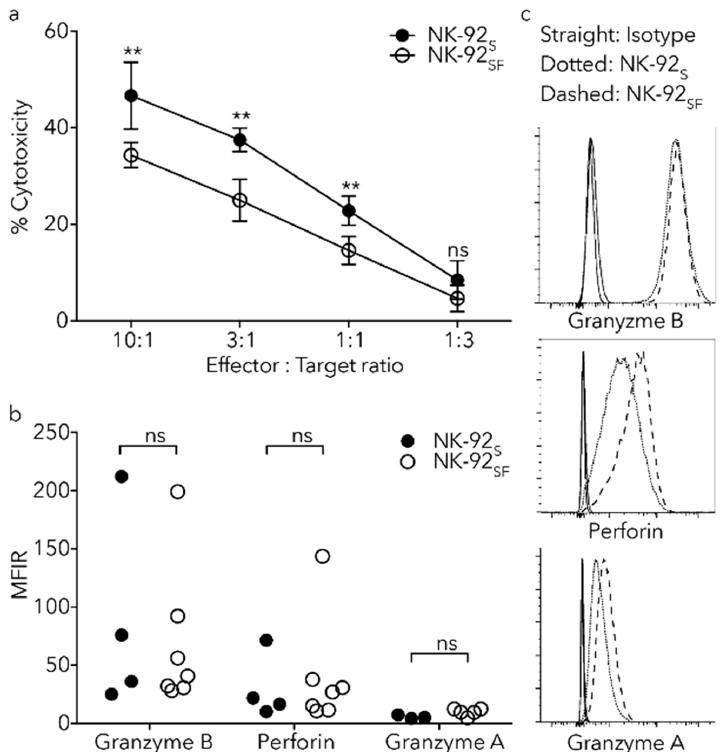
Figure 5. Reduced degranulation rate and cytotoxicity against K562 in NK-92 SF cells. ( a ) Chromium release assay, with K562 cells as target cells, show reduced cytotoxicity in NK-92 SF cells at designated effector:target ratios. Each data point represents the mean (+SD) of two independent assays performed in triplicates. ( b ) Load of Perforin, Granzyme A, and Granzyme B in NK-92 S and NK-92 SF cells as shown by gMFI ratio to isotype do not alter between culture conditions. Each bar represents the mean (+SD) of four independent assays performed in single or duplicate experiments. ( c ) Representative histograms showing indicated marker expression. Straight line shows isotype control, dotted line shows receptor expression on NK-92 S cells and dashed line shows receptor expression on NK-92 SF cells. Statistical significance (** p < 0.01). ( a ): 2way ANOVA and ( b ): Wilcoxon test was used.